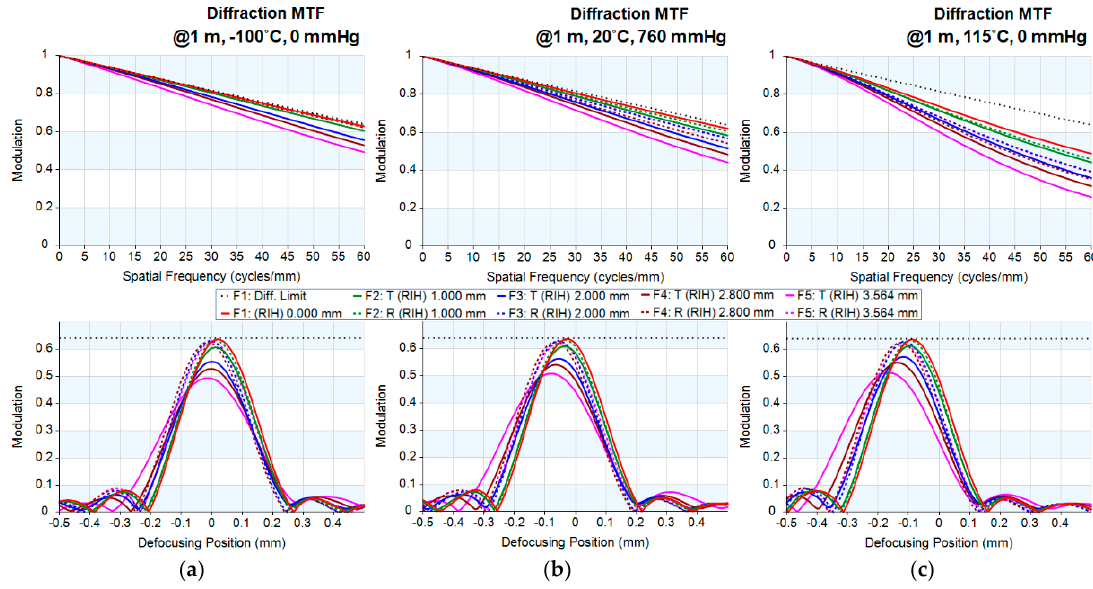
Figure 5. MTF and through-focus MTF of the lens at an object distance of 1 m in space ambient